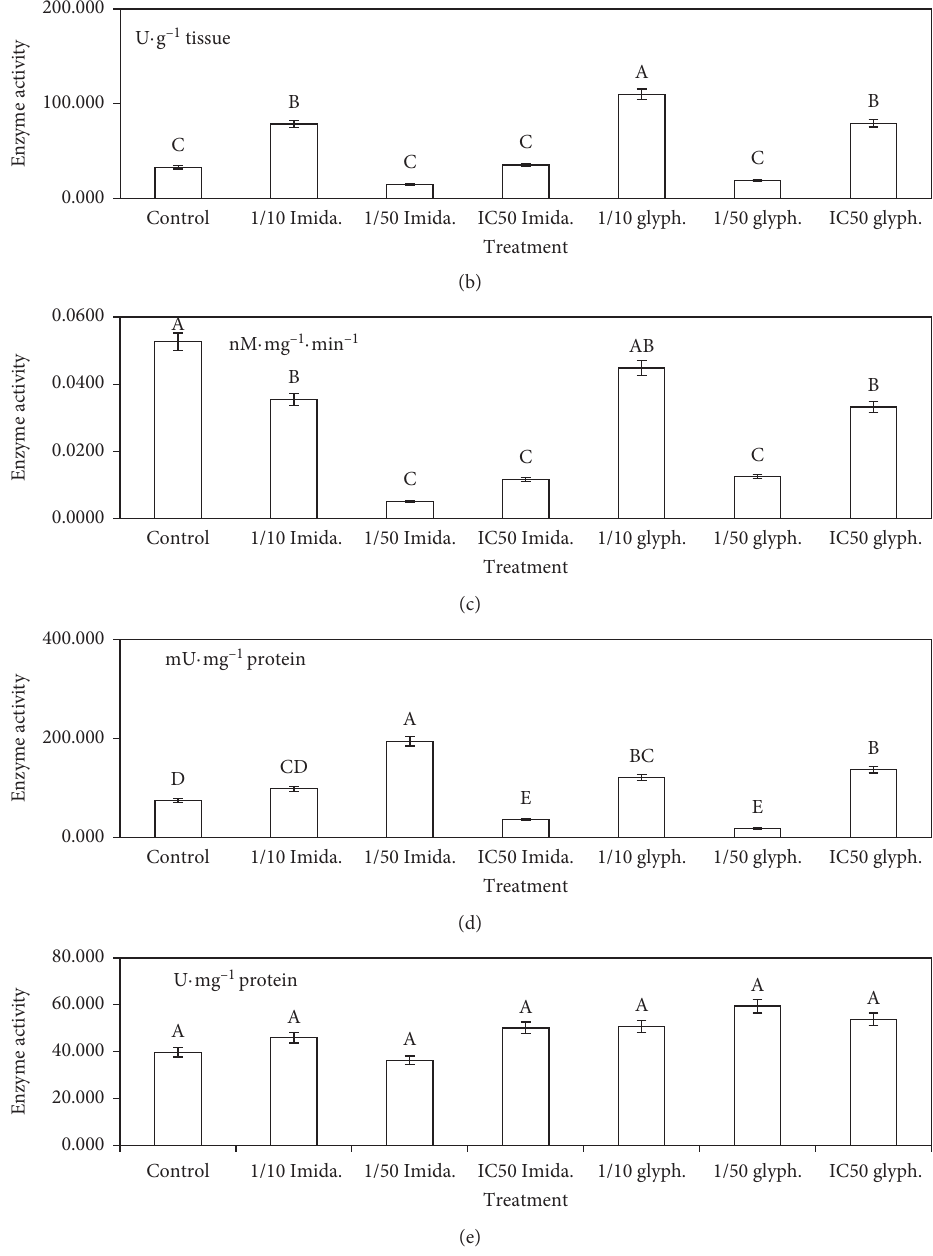
Figure 4: (a) Glutathione content (GSH), (b) catalase (CAT), (c) glutathione-S-transferase (GST), (d) glutathione peroxidase (GPx), and (e) glutathione reductase (GR) activities, respectively, in WPM-Y.1 cells exposed to different concentrations (mM) of imidacloprid and glyphosate. Each value represents the mean of 3 replicates ± SE. The same letters indicate no significant difference at the 0.05